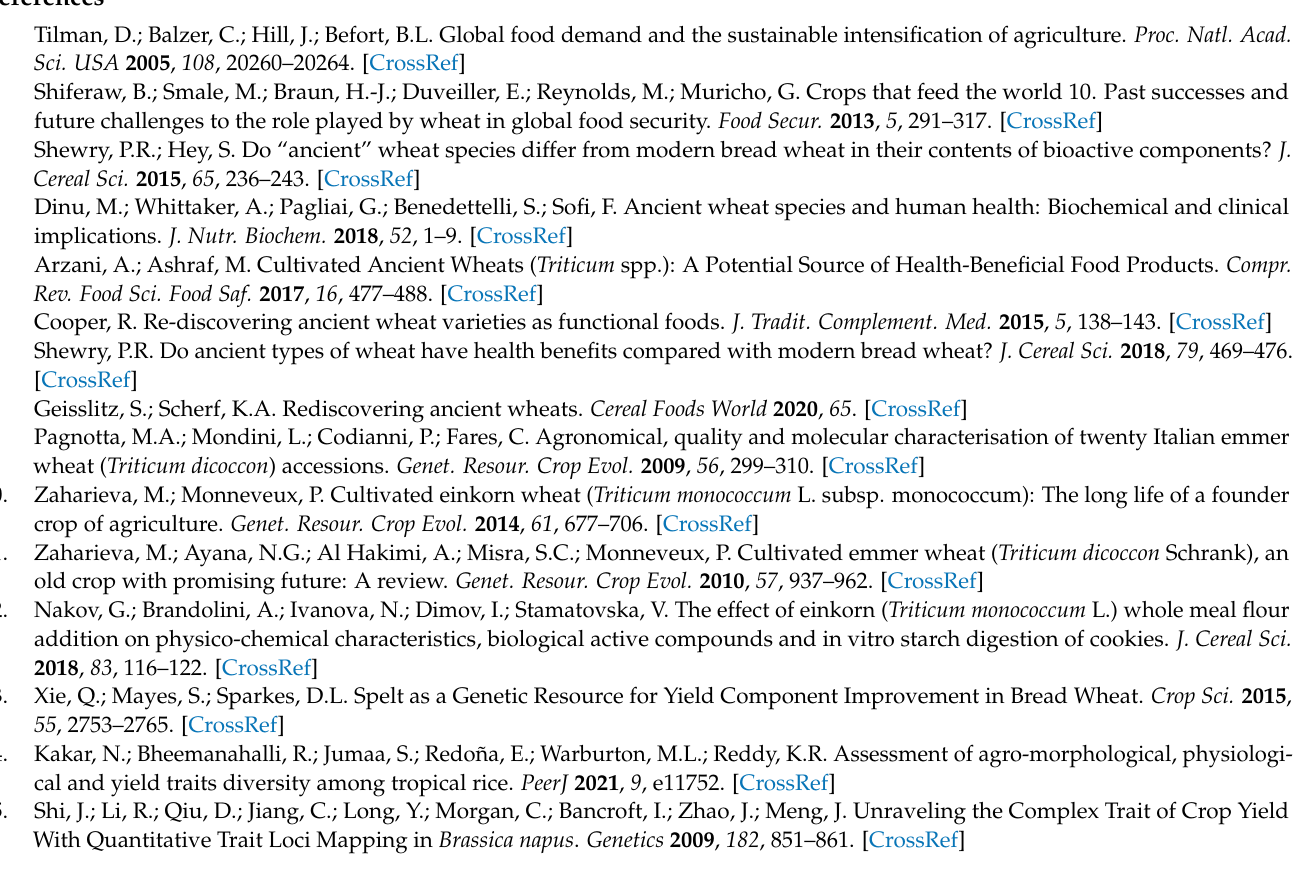
Table S1: The set of data used for the evaluation of the effect of species, cultivars, growing year on agro-morphological and quality traits in ancient